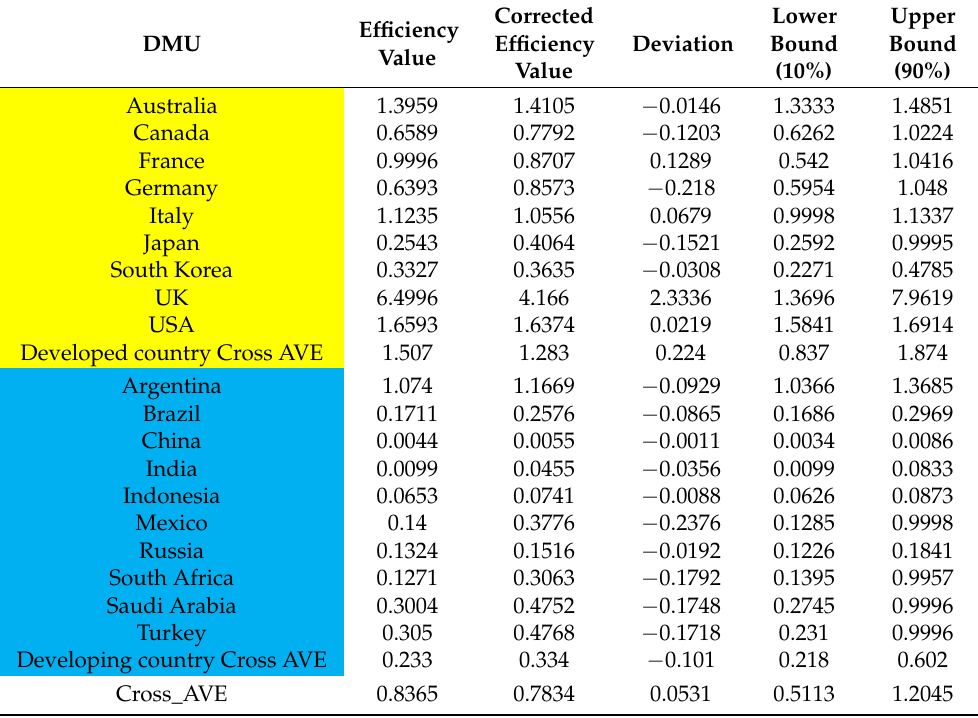
Table 4. Efficiency values and 80% confidence intervals for G20